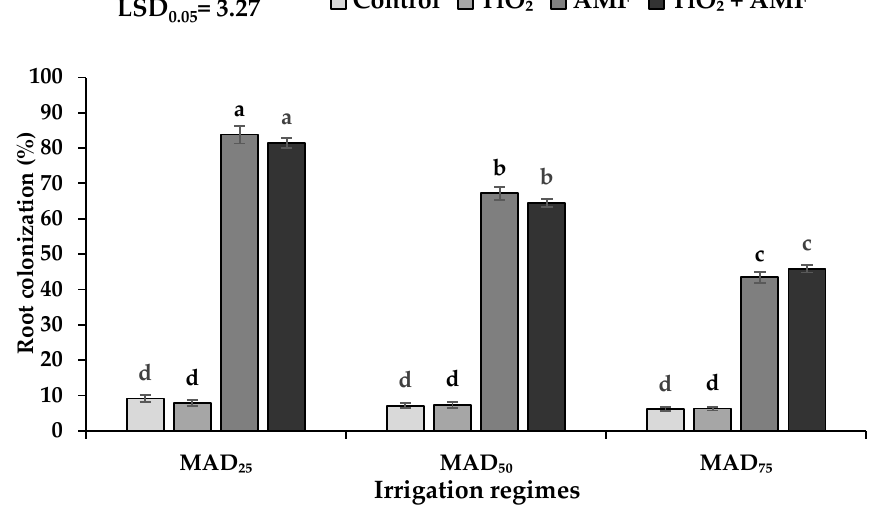
Figure 1. The root colonization of sage as influenced by different irrigation regimes and fertilizer sources. MAD 25 , MAD 50 , and MAD 75 indicating non-stressed, moderate, and severe drought stress, respectively. AMF: arbuscular mycorrhizal fungi; TiO 2 : titanium dioxide nanoparticle. Different letters indicate significant differences at the 5% level according to least significant difference (LSD)